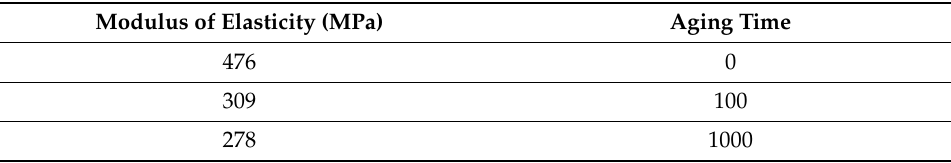
Figure 11. Shear stress–shear strain diagram for samples thermally aged at 150 °C. Table 3. Modules of elasticity vs. thermal aging time.